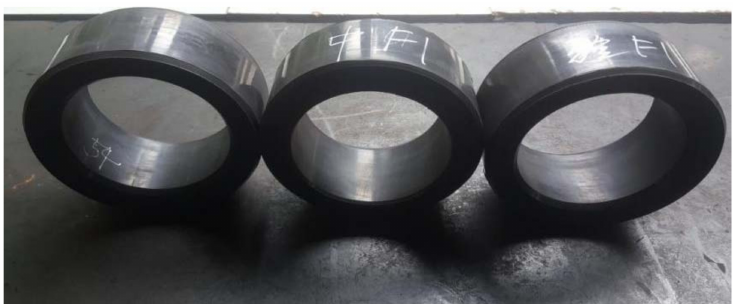
Figure 15. Packer rubber packing elements from the 105 MPa/215 ◦ C experiment. Table 3. Dimensionalparametersofthepacker’srubberpackingelementsinthe105MPa/215 ◦ Cexperiment. Description Dimensional Parameters Characteristic Outside diameter (mm) 146 Inner diameter